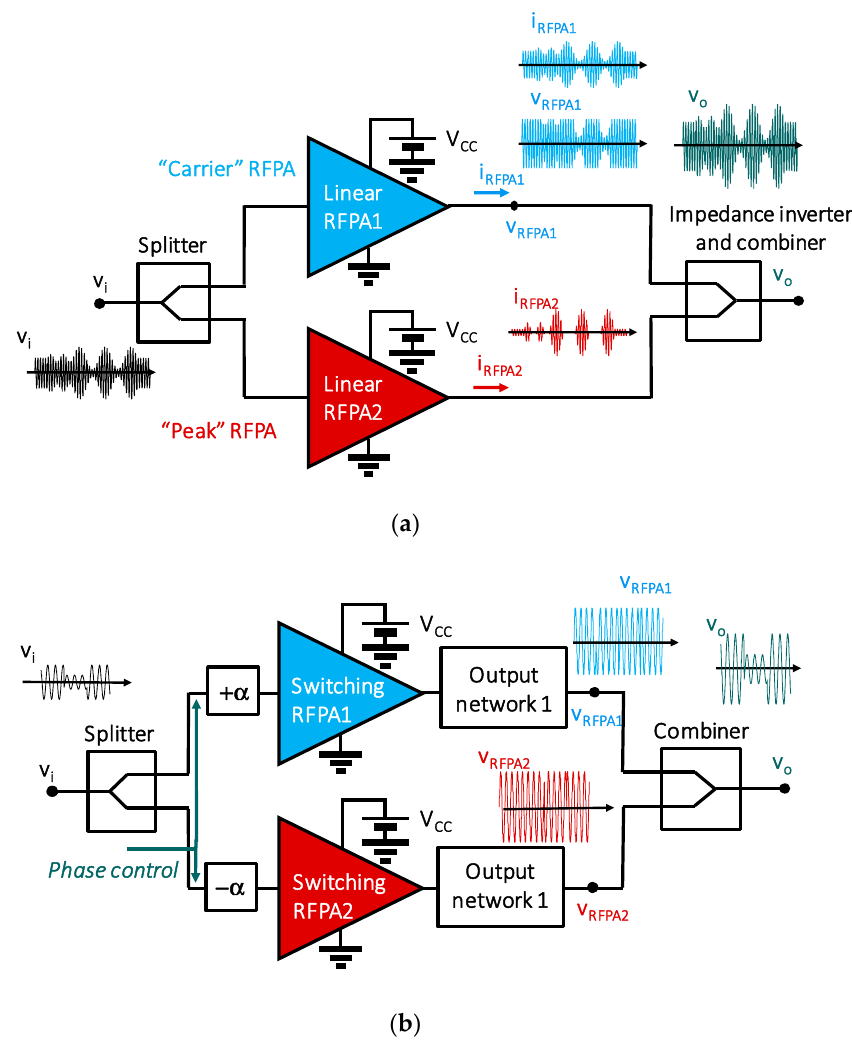
Figure 3. Conventional block diagram of techniques based on an arrangement of RFPAs. ( a ) Doherty technique; ( b ) Outphasing technique.